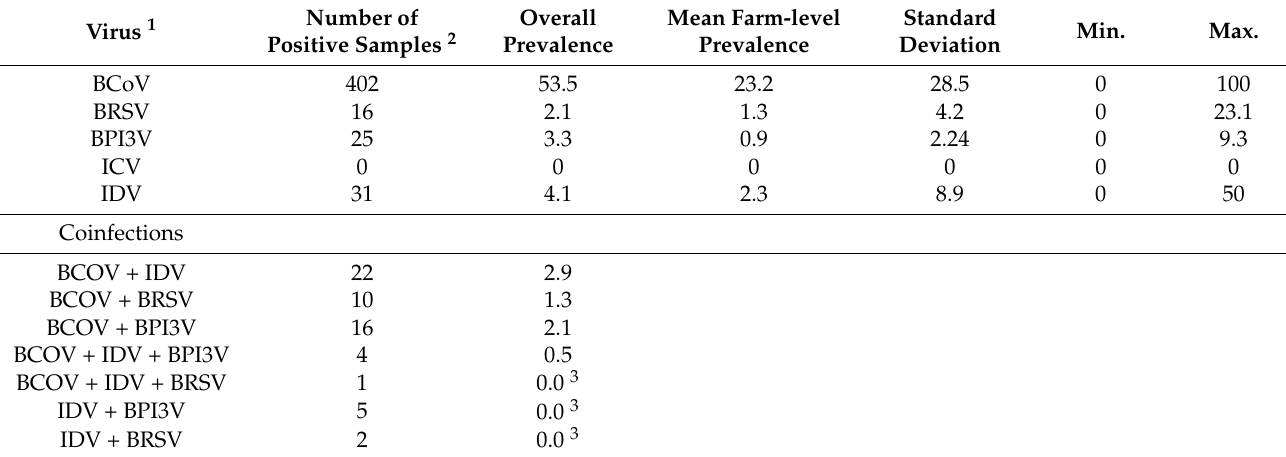
Table 3. Overall prevalence and farm-level prevalence (including mean, standard deviation, minimum, and maximum values) of respiratory pathogens BCoV, BRSV, BPI3V, ICV, and IDV in Swiss veal calves from 33 fattening farms, as well as overall prevalence of swab samples positive for more than one respiratory virus (based on 764 nasopharygeal swab samples).